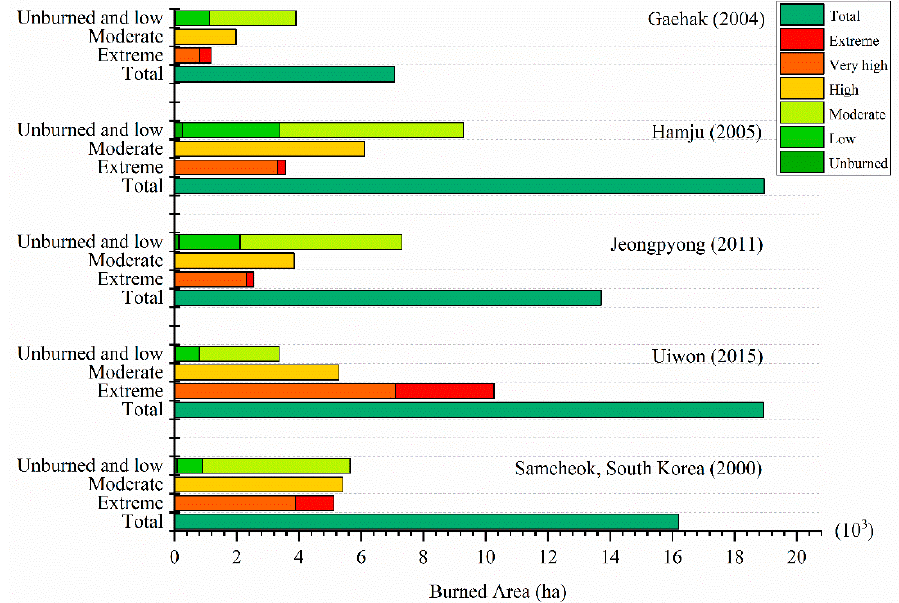
Figure 8. Burn severity assessment by dNBR of burned areas in the two study areas.